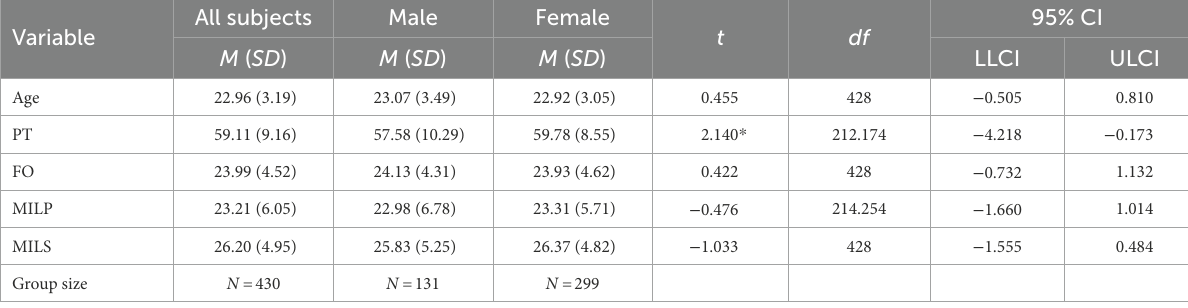
TABLE 2 Demographics and t -test for possible gender differences in major variables.